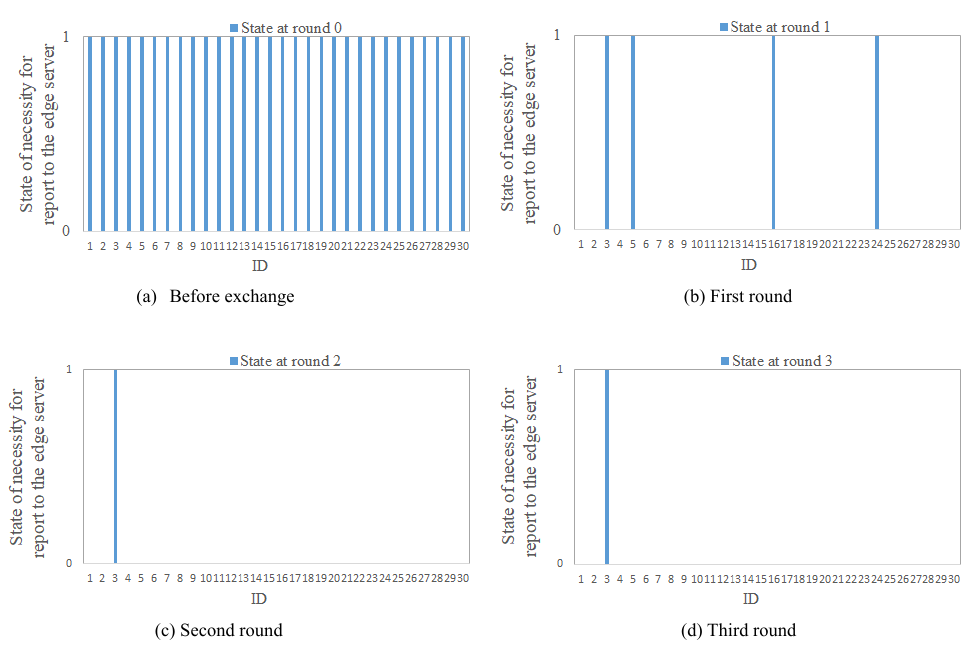
Figure 11. Number of necessary reports to the edge server in Scenario 3 regarding the proposed scheme (State 1 refers to the state in which the vehicle needs to report to the edge